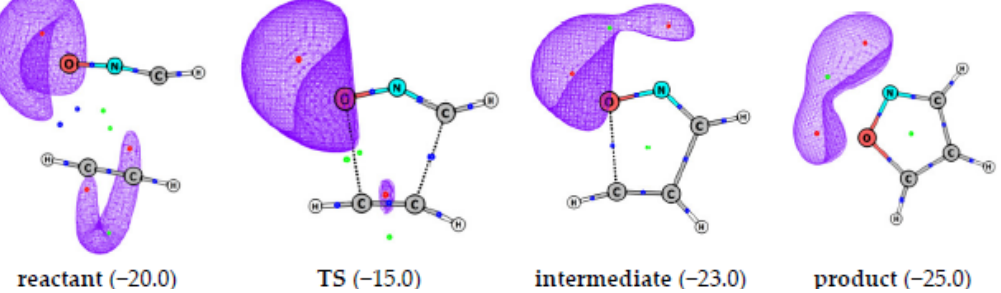
Figure 8. MESP topography and isosurfaces along the reaction path for the 1,3-dipolar cycloaddition between HCNO and HCCH, at B3LYP/6-311++G (d, p) level theory. Red, blue and green dots correspond to (3, +3), (3, − 1) and (3, +1) CPs, respectively. Isosurface values in kcal/mol, in